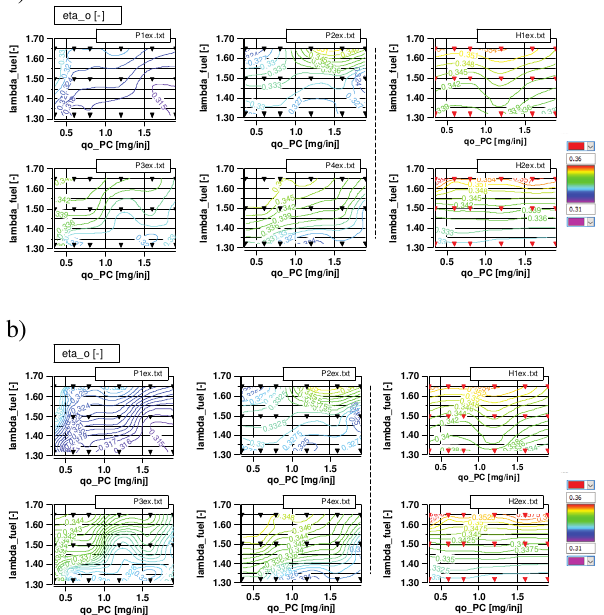
Fig. 14. The maps of overall efficiency achieved for prechamber type P (a) and type H (b) Additionally a differential analysis of the efficiency achieved for the prechamber H1 and H2 showed that: - in the range of average excess air coefficient values, the values for both H type prechambers are similar, - with small values of excess air coefficient and lower fuel doses to the prechamber, the H1 prechamber (smaller number of outflow channels) achieves higher efficiency, - for the limit values of λ > 1.6 greater efficiency is ob- tained using the H2 prechamber.